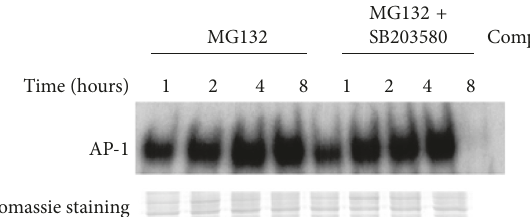
Figure 8: The activation of AP-1 induced by proteasome inhibition is not blocked by the inactivation of P38 MAPK.